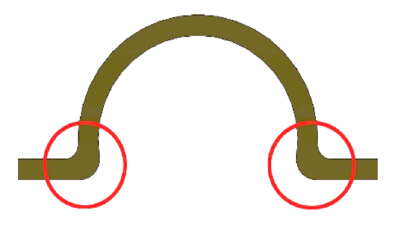
Figure 13. Stress concentration in matrix housing.